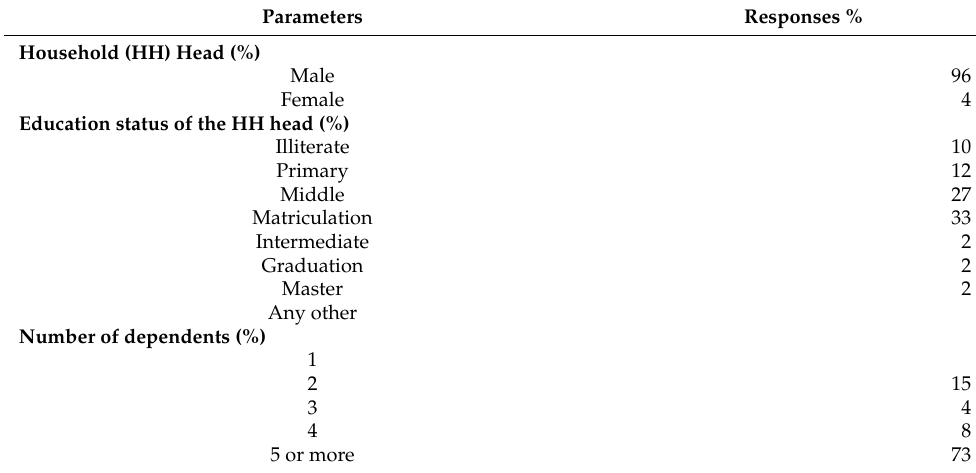
Table 1. Socio-economic features.